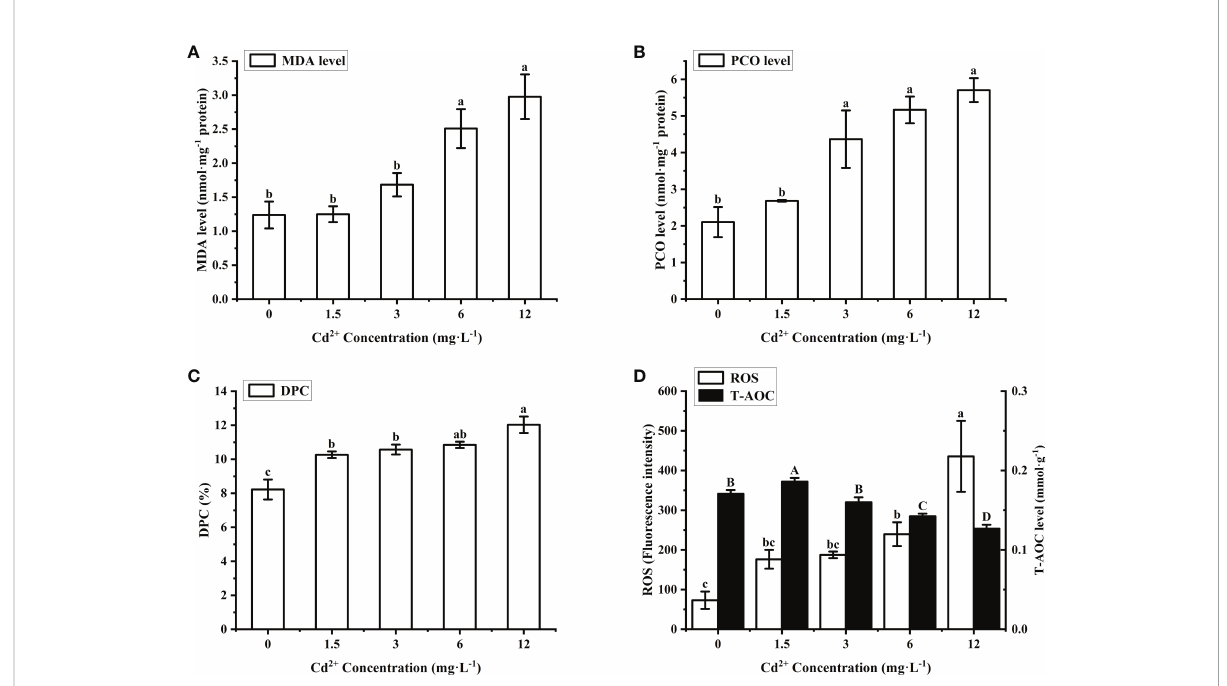
FIGURE 1 Effects of Cd on MDA, DPC, PCO, ROS and T-AOC in M. meretrix ovary. (A) MDA level; (B) PCO level; (C) DPC level; (D) ROS (white bars) and T- AOC (black bars) contents. Different letters indicate signi fi cant ( P < 0.05) differences among groups as revealed by Tukey ’ s post-hoc multiple comparison tests; Data are expressed as means ± SE (n =